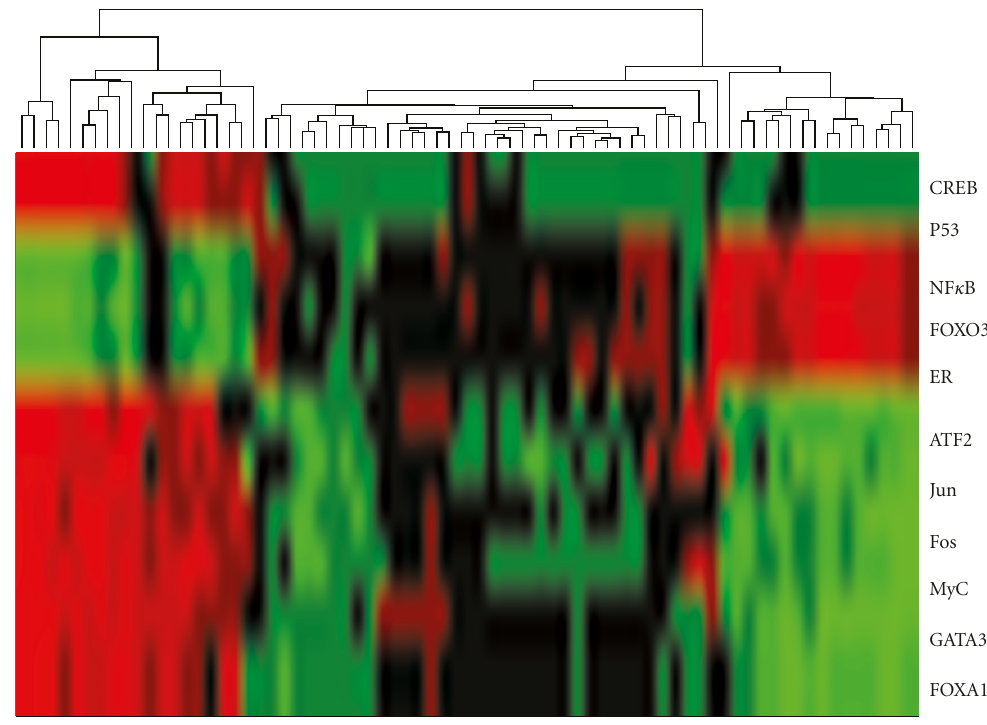
Figure 12: Estimated TF activities in ER + patients samples. The samples (columns) are arranged according to hierarchical clustering and the TFs (rows) according to the estimated clusters by the Gibbs sampling algorithm.